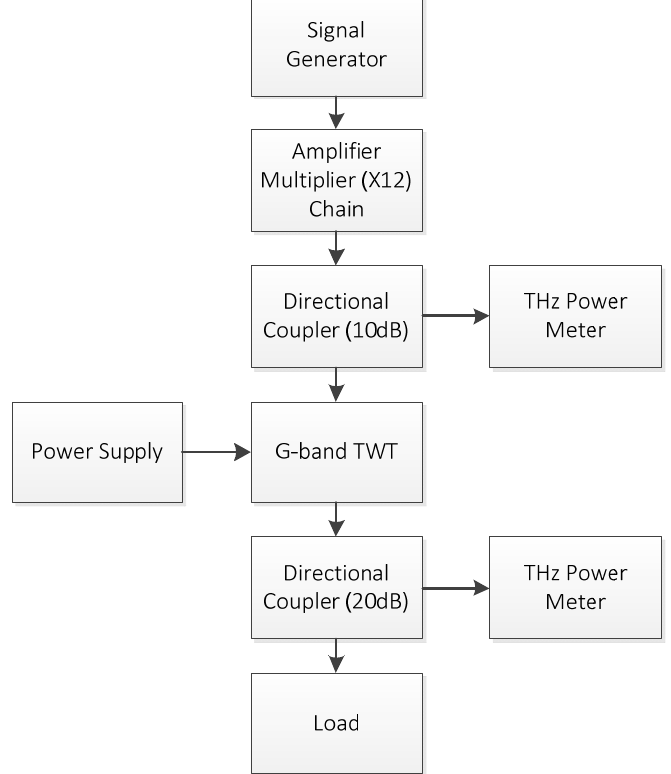
Figure 14. Block diagram of the experimental setup.